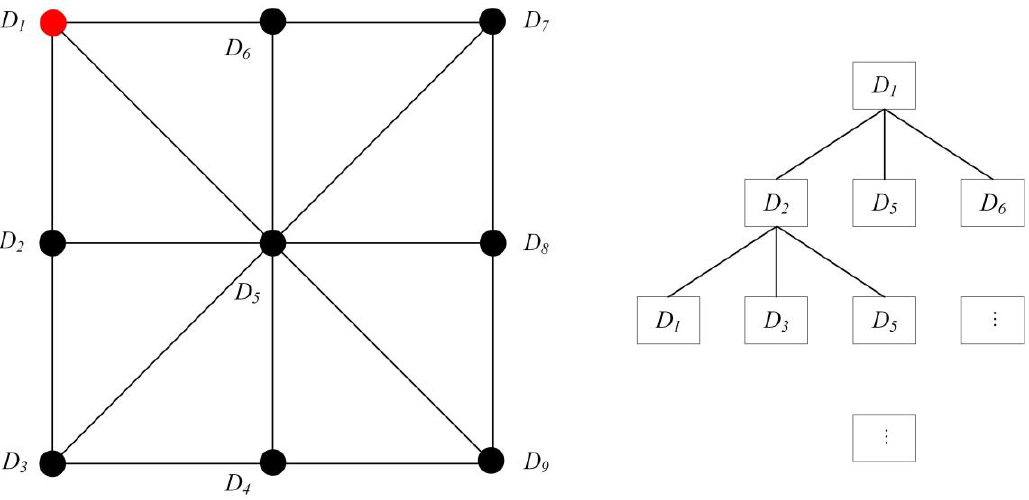
Figure 3. Diagram for the Neighborhood Borehole Solution.